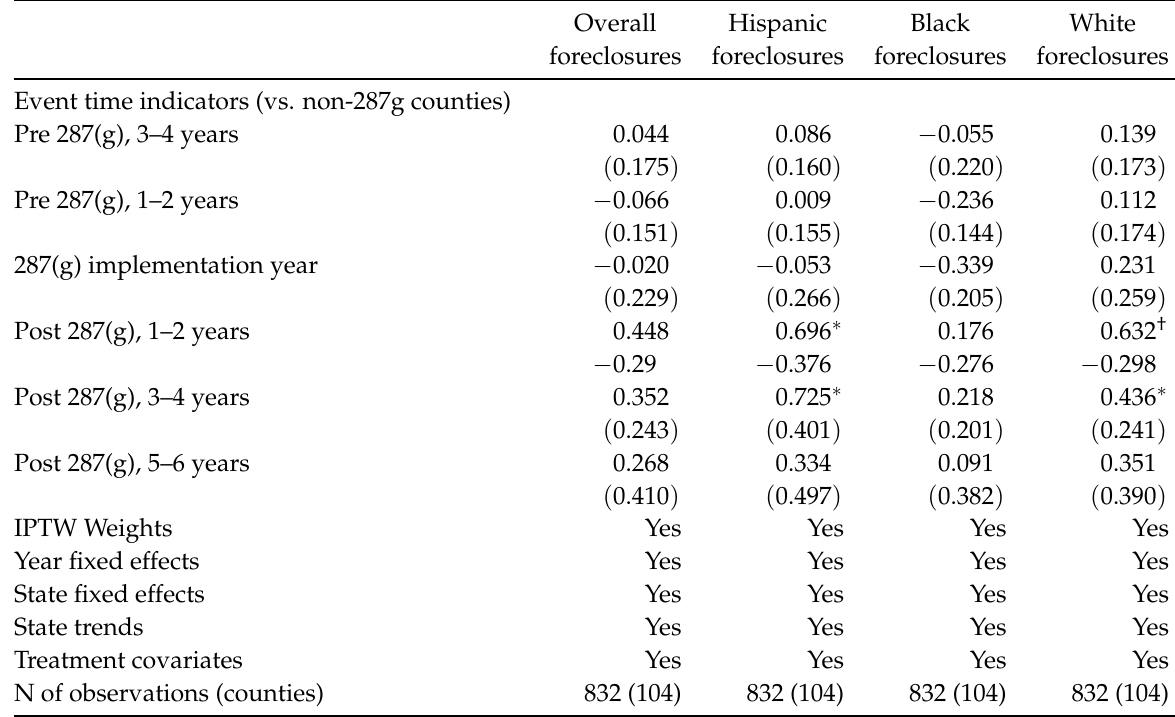
Table 3: Difference-in-difference estimates of 287(g) participation on county foreclosure rates (2005–2012) among 287(g) applicant